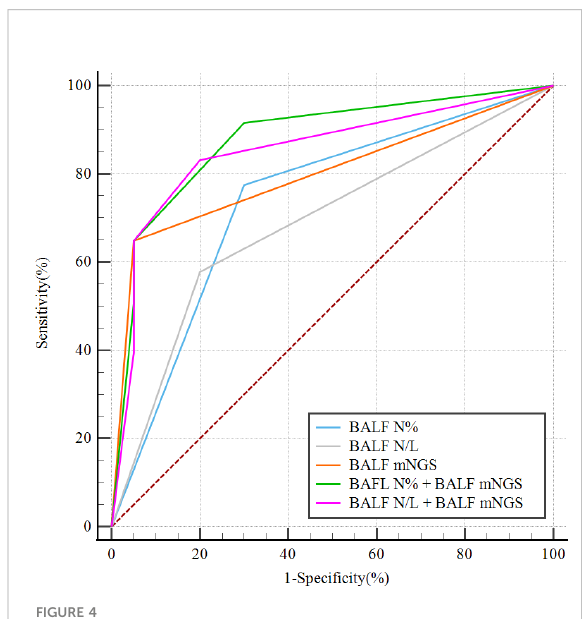
FIGURE 4 ROC curves of dichotomous state variables of BALF mNGS combined with BALF N% (model 1) or BALF N/L (model 2) for predicting PNID, compared with single variables alone. Dichotomous state variables were separated in accordance with cutoff values of BALF mNGS, BALF N%, and BALF N/L. AUC model 1 = 0.879 (95% CI 0.793 – 0.938); AUC model 2 = 0.853 (95% CI 0.763 – 0.919); AUC BALF N% = 0.737 (95% CI 0.635 – 0.824); AUC BALF N/L = 0.689 (95% CI 0.583 – 0.782); AUC BALF – 0.876). AUC, area under the mNGS = 0.799 (95% CI 0.702 curve; BALF, bronchoalveolar lavage fl uid; mNGS, metagenomic next-generation sequencing; N, neutrophils; N/ L, ratio of neutrophils to lymphocytes; PNID, pulmonary non- infectious disease; ROC, receiver operating